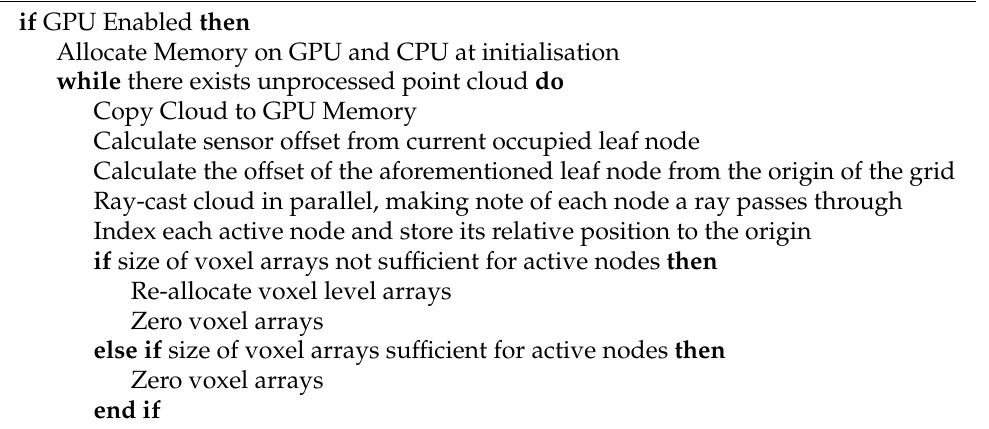
Algorithm 1 Processing a point cloud using Nanomap